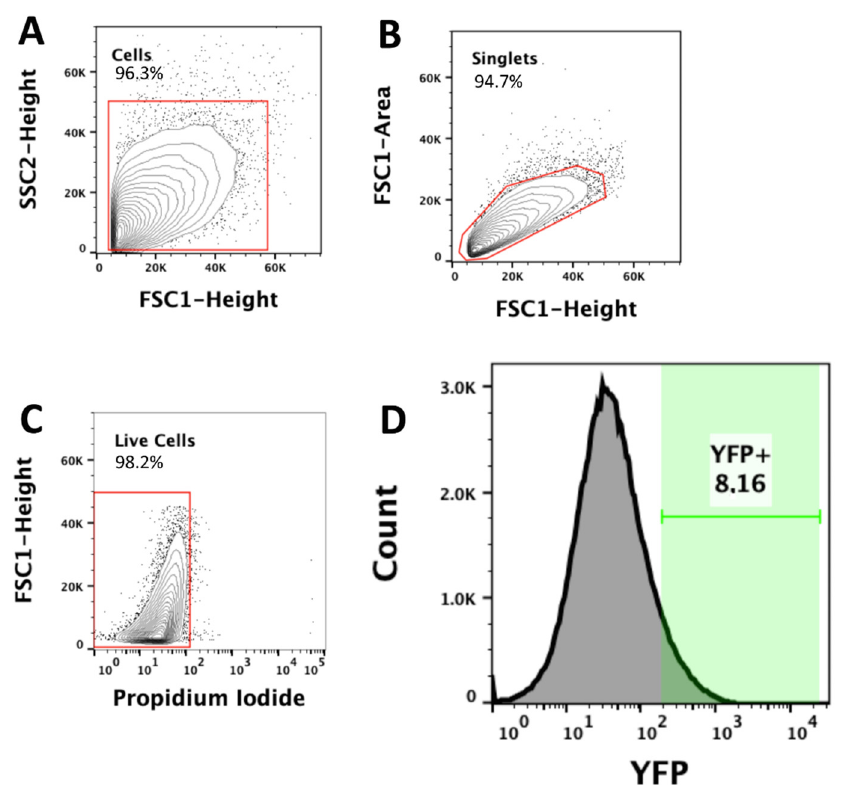
Figure 8. Gating strategy for amygdala pyramidal neurons cell purification. Amygdala pyramidal neurons, excited with a ~488 nm blue laser, were sorted on the basis of their physical parameters (forward scatter, FSC, and side scatter, SSC, light scattering) ( A ), singlets ( B ), propidium iodide negative (live cells) ( C ) and Yellow Fluorescent Protein (YFP) intensity ( D ), and the positive cells were collected. Cells are sorted by high-speed cell sorting (Moflo Astrios EQ).